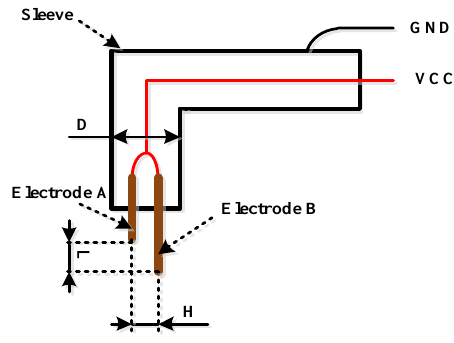
Figure 1. Schematic diagram of the structure of the bubble detection sensor.